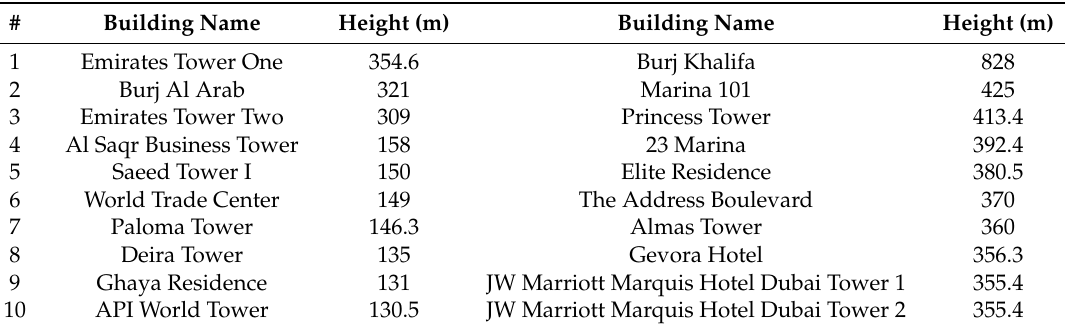
Figure 15. Dubai in 2000 and 2020. Table 25. Dubai’s 10 tallest skyscrapers in 2000 and 2020.